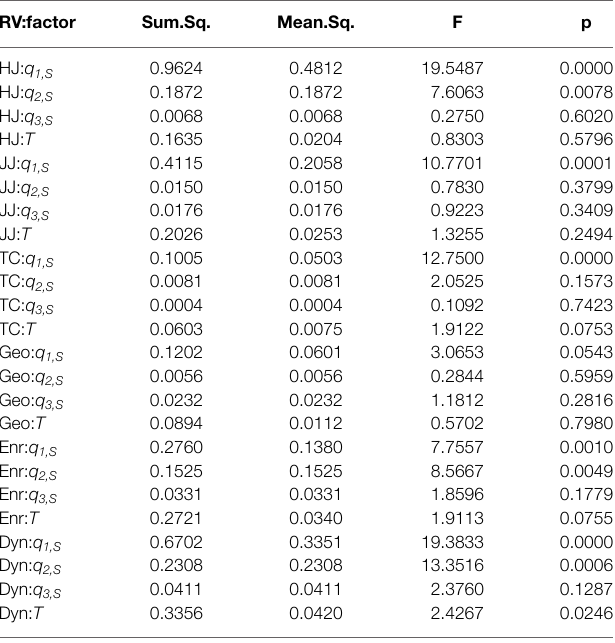
TABLE 4 | Results of ANOVA